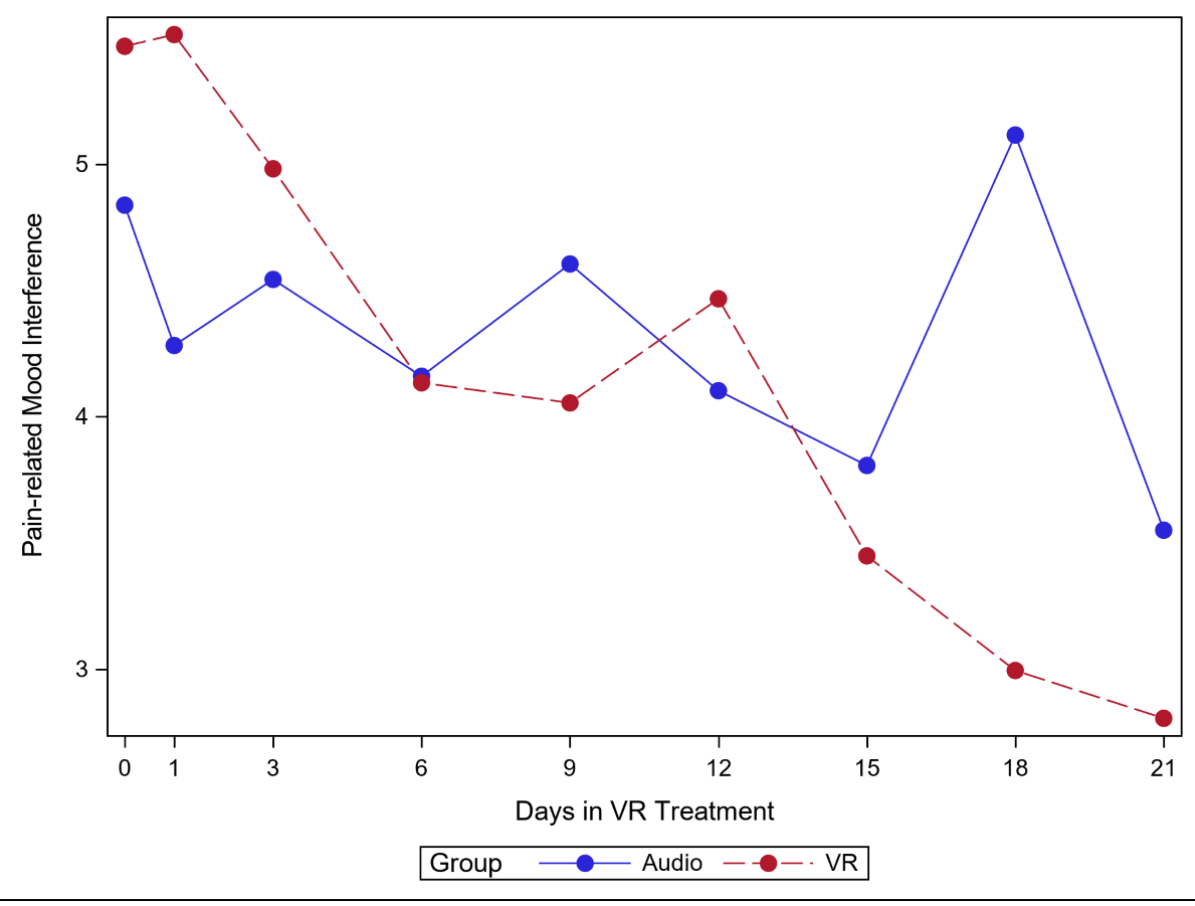
reaching significance at day 1 (audio<VR; P= .02) and on day 18 (VR<audio, Figure 7; P=